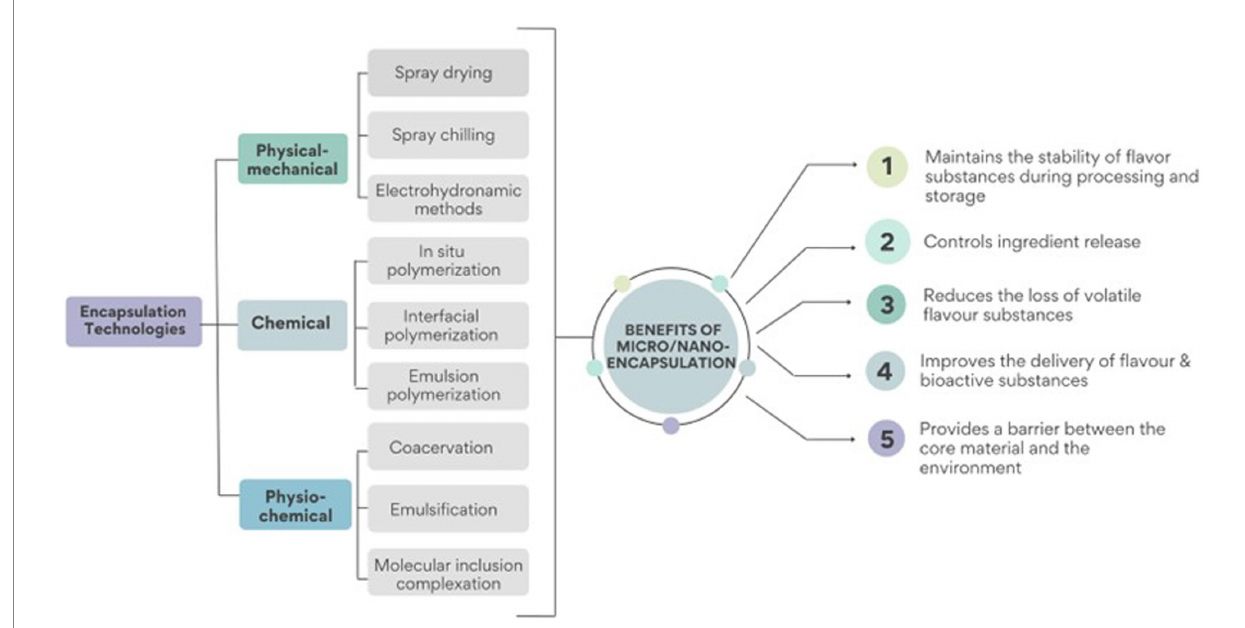
FIGURE 2 Encapsulation technologies can be classified into three main groups: (1) physical–mechanical methods, (2) chemical methods, and (3) physicochemical methods. The application of these technologies results in improved flavour stability during processing and storage, as well as improved delivery and release of flavour substances among other